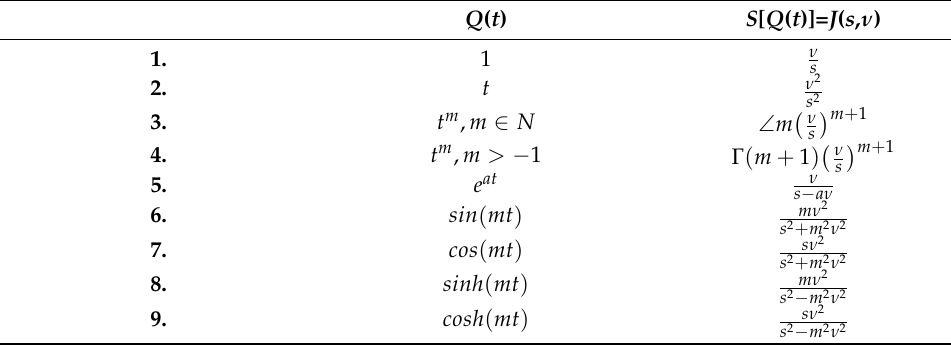
Table 2. Chart regarding the Shehu transform